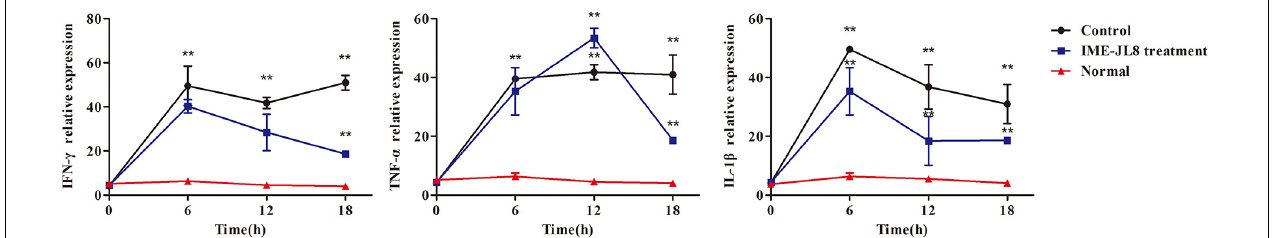
FIGURE 7 | Cytokine levels. The fish were injected intraperitoneally with C. freundii CF8 (2 × 10 9 CFU/carp). One hour later, IME-JL8 (10 8 PFU/mL, 100 µ L/fish) or PBS (100 µ L/fish) were introduced intraperitoneally to the fish. At the indicated times, the levels of TNF- α , IL-1 β and IFN- γ in the blood of the different treatment groups were determined by qRT-PCR. ** P values of < 0.05 compared with the PBS treated control. The mentioned experiment was repeated three times. Each data is expressed as mean ± SD from three biological